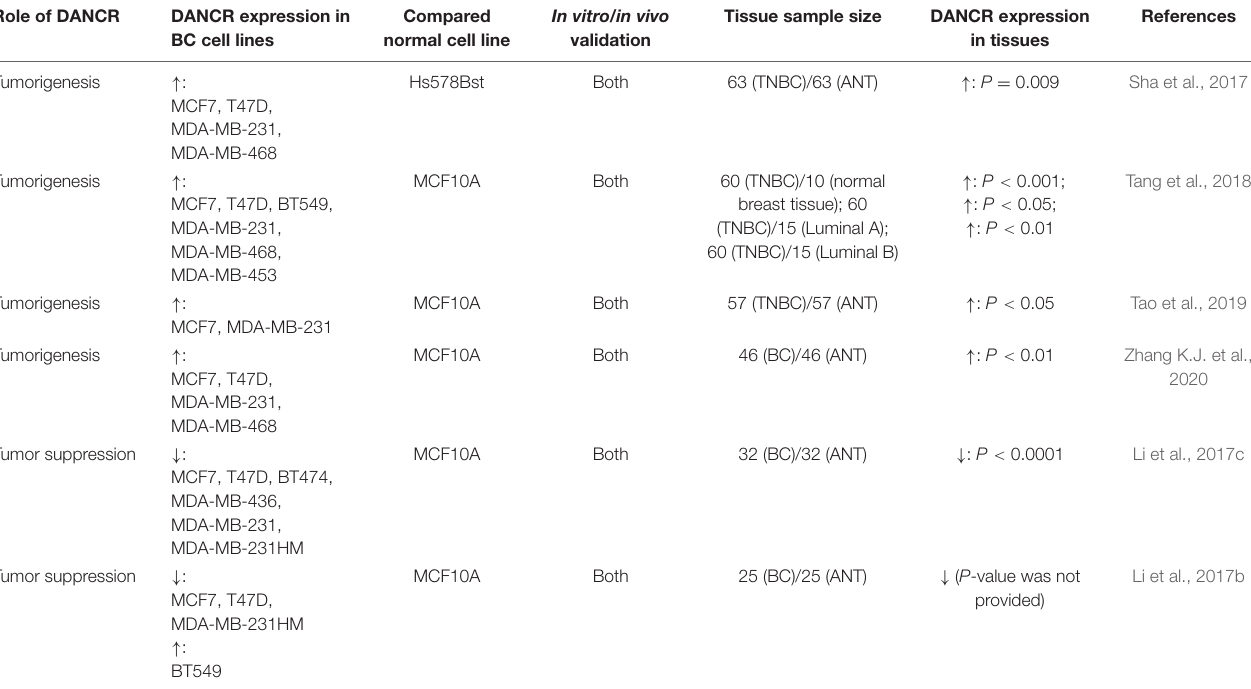
TABLE 3 | Information of DANCR in breast cancer from six research